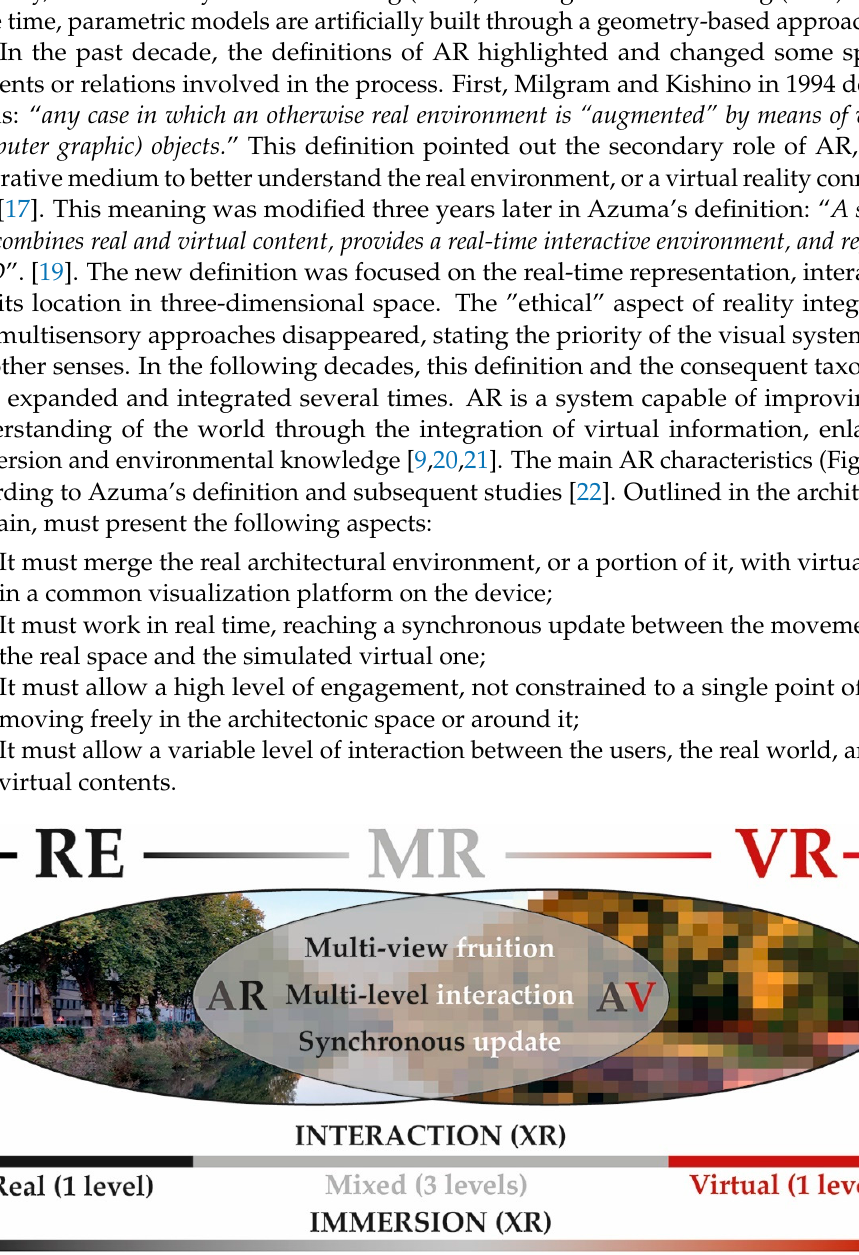
[23]. Interaction occurs only with virtual information through different devices. In a sym- metrical position to AR, augmented virtuality (AV) enriches the virtual world with scenes from the real one, enhancing the sense of presence and interaction with an artificial envi- ronment [24]. The domain between AR and VR is occupied by mixed reality (MR), in which real and virtual contents coexist, proposing an integrated, flexible, immersive, in- teractive platform for experience enhancement [25,26]. Interaction, in this case, is mixed, as it works on three different levels: At the real level, it occurs with body movement in the real space. At the virtual level, it happens only with virtual elements visualized in devices. The third level connects the real and the virtual levels by manipulating elements such as markers. [27]. All ofAll these environments (Figure 3) are characterized by different levels of immersion (i.e., immersive, semi-immersive, or non-immersive) depending on the type of device and visualization. The reduced field of view and precise tracking requirements of devices for AR visualization lead to the consideration of AR as a low-immersive repre- sentation technique. In general, the integration between personal devices, sensors, and large projection screens justifies increasing the level of immersion towards VR, but losing the connection with reality, which is very useful in the architecture domain. 3. AR Project The AR design defines the starting point of the whole chain, decisive for the identifi- cation of both the main AR characteristics and its development. It is relevant to evaluate some aspects to prepare a suitable design path (Figure 4). Sidani [28] presents a helpful example, although focused only on the AECO world. First, the specific domain must eval- uate either the content conveyed or the boundary conditions. Moreover, the primary pur- pose of AR must be clarified, as well as the final users. Based on these aspects, the outdoor or indoor AR conditions must be evaluated. Finally, it is crucial to assess the characteris- tics of the digital data merged with reality, the connection, and the capacity to increase contextual reading and understanding.